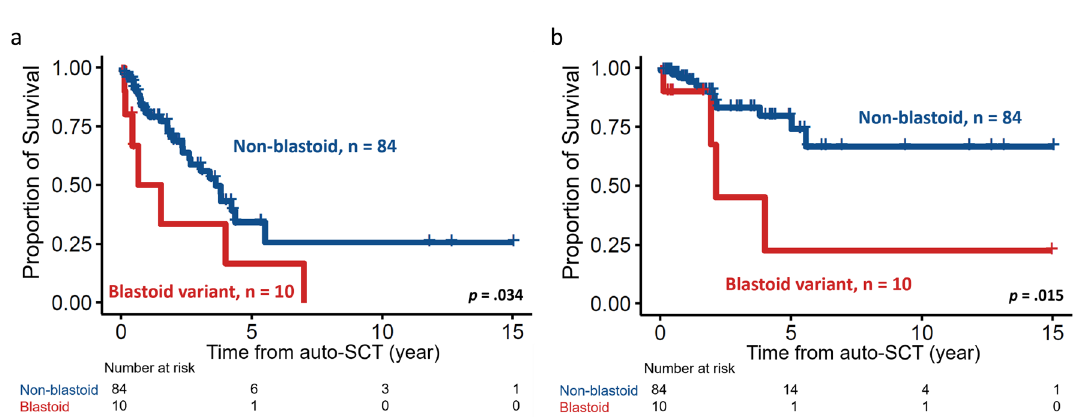
Figure 2. Kaplan–Meier plots stratified by morphologic variant of MCL. ( a ) PFS and ( b ) OS of 94 MCL patients with blastoid or non-blastoid variant. Patients with blastoid variant had significantly inferior PFS and